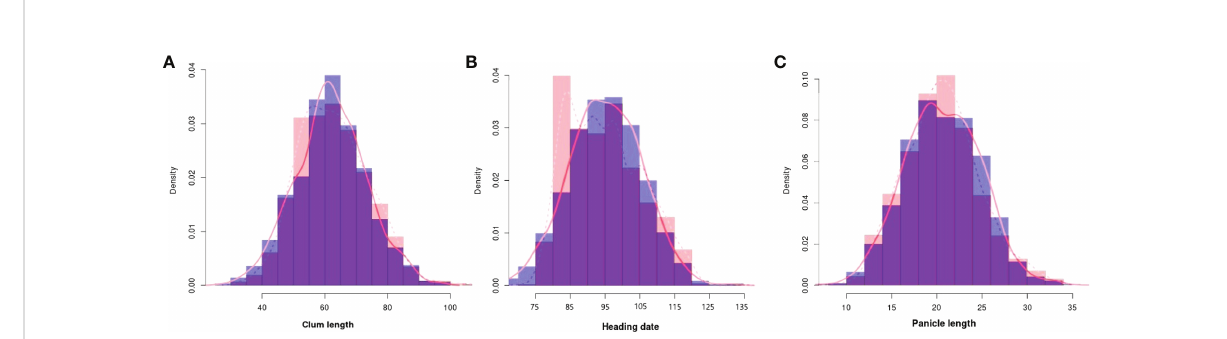
FIGURE 6 Frequency distribution for all the traits used for the genome-wide association study. (A) Clum length, (B) Heading date, and (C) Panicle length. The histograms with purple colors are normal as expected while other colors denote difference from normal distribution. The observed and expected normal distributions fi tting for data were represented with dashed and solid red lines,